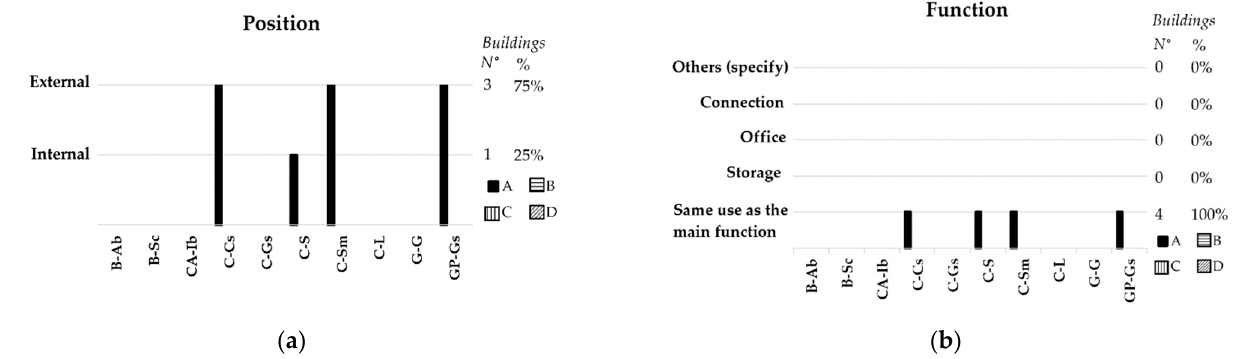
Figure 20. Section 2B CARTIS-Building. Added block ID: ( a ) Position; ( b ) Function.